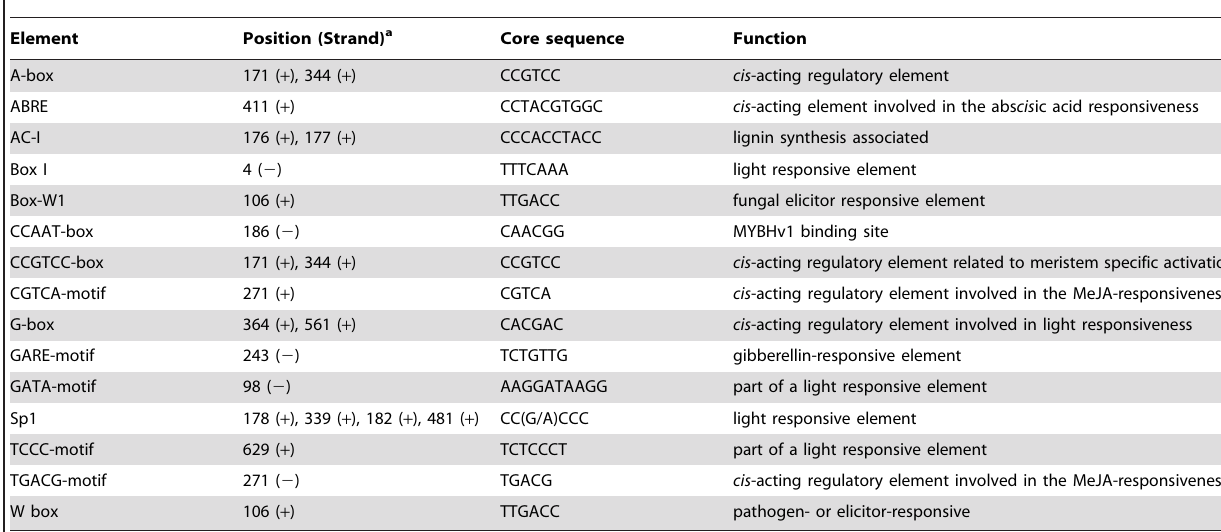
Table 1. The predicted cis -elements in TaWRKY71-1 promoter